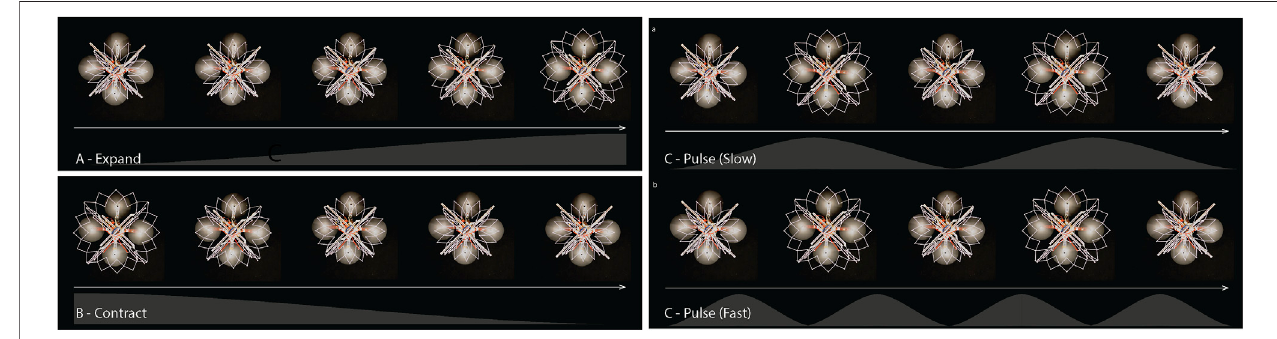
FIGURE 13 | (A) Expand, (B) Contract and (C) Pulse